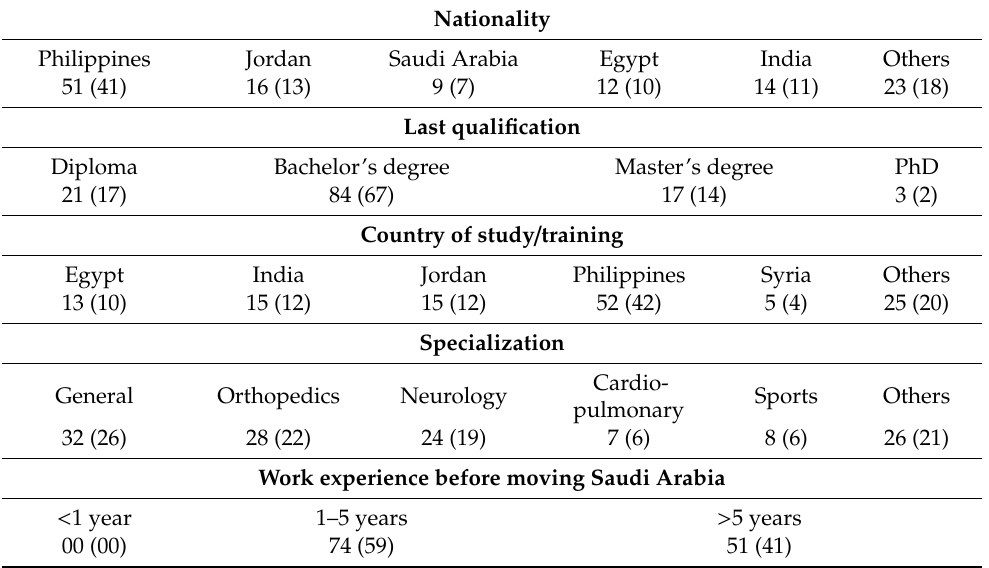
Table 2. Demographic and professional characteristics of respondents. Percentages are provided in